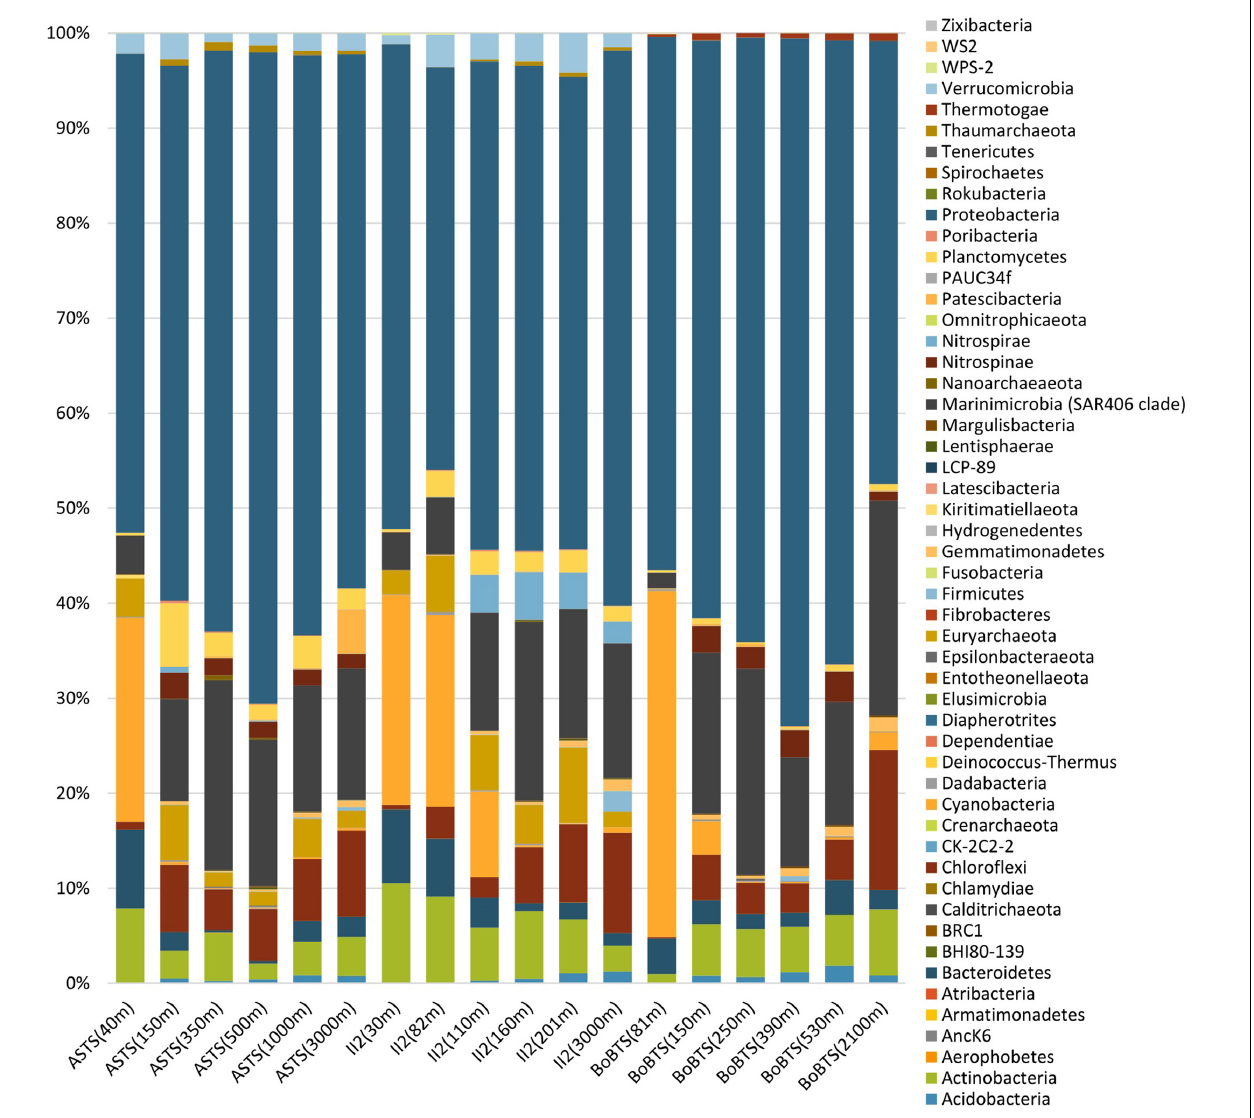
FIGURE 2 | Percentages of relative abundance (x-axis) and depth-wise representation of bacterial phyla (y-axis) at the Arabian Sea time series (ASTS) and India’s Idea 2 (II2) in the Arabian Sea and Bay of Bengal time series (BoBTS) in the Bay of